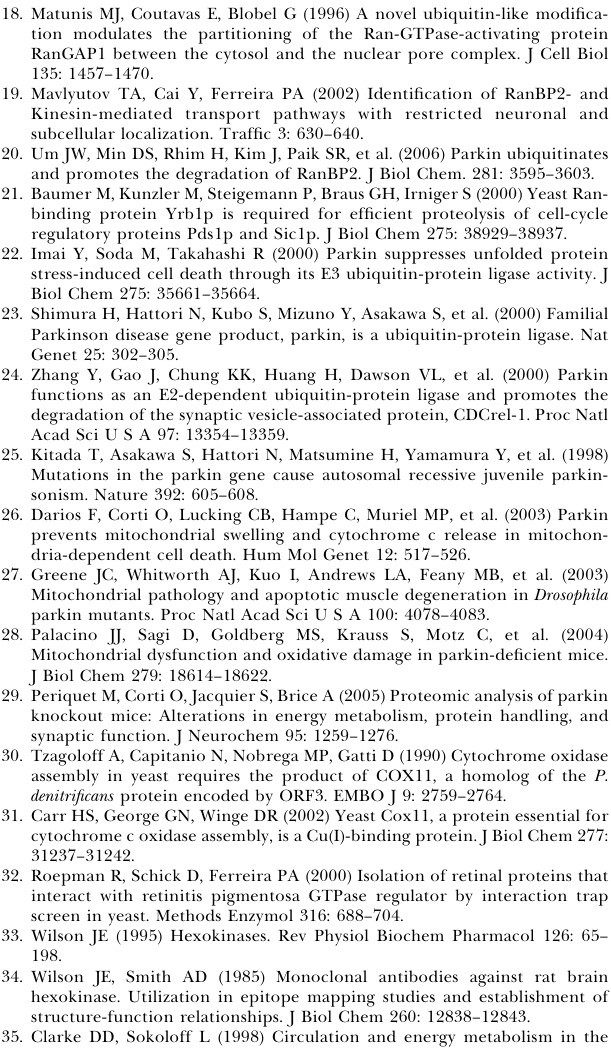
Figure S1. Western Blot Analysis of the Association of LD of RanBP2 with HKI and Cox11 across Tissues GST-JX2 (2.2 l M) was incubated with different tissue extracts ( ; 2.0 mg) and the GST-JX2 coprecipitates from seven different tissues were analyzed by Western blot with the antibodies against HKI and Cox11. The LD of RanBP2 associated with the HKI and Cox11 in all seven tissues tested. Figure S2. Immunostaining of Radial Cryosections of Wild-Type ( þ / þ ) and Heterozygote ( þ / (cid:1) ) RanBP2 Mice Retinas with Anti-HKI and (cid:1) Cox11 Antibodies A1 and B1 represent magnifications of just the distal section of the retina (inner segment subcellular compartment of the photosensory neuron layer). Note the partial delocalization of HKI to the myoid subcompartment of the inner segment of photoreceptor neurons in þ / (cid:1) mice (B1) and decreased levels of HKI in the inner plexiform (synaptic) layer of the retina (A and B). This is reflected by a significant increase and decrease of the mean fluorescence intensity (in arbitrary units) of HKI in the myoid and inner plexiform (synaptic) layers, respectively (E). AU, arbitrary unit; ROS, rod outer segment; RIS, rod inner segment; ONL, outer nuclear layer; OPL, outer plexiform layer, INL, inner nuclear layer; IPL, inner plexiform layer; GCL, ganglion cell layer; E and M are, respectively, the ellipsoid (mitochondria-rich) and myoid compartments of photosensory neurons.